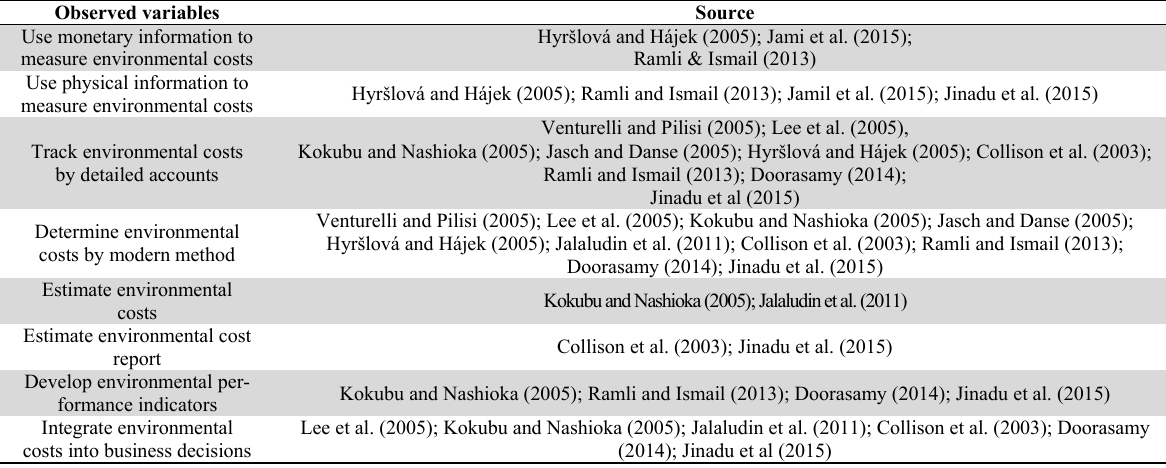
Observed variables reflecting the level of ECMA application Observed variables Source Use monetary information to measure environmental costs Use physical information to measure environmental costs Track environmental costs by detailed accounts Determine environmental costs by modern